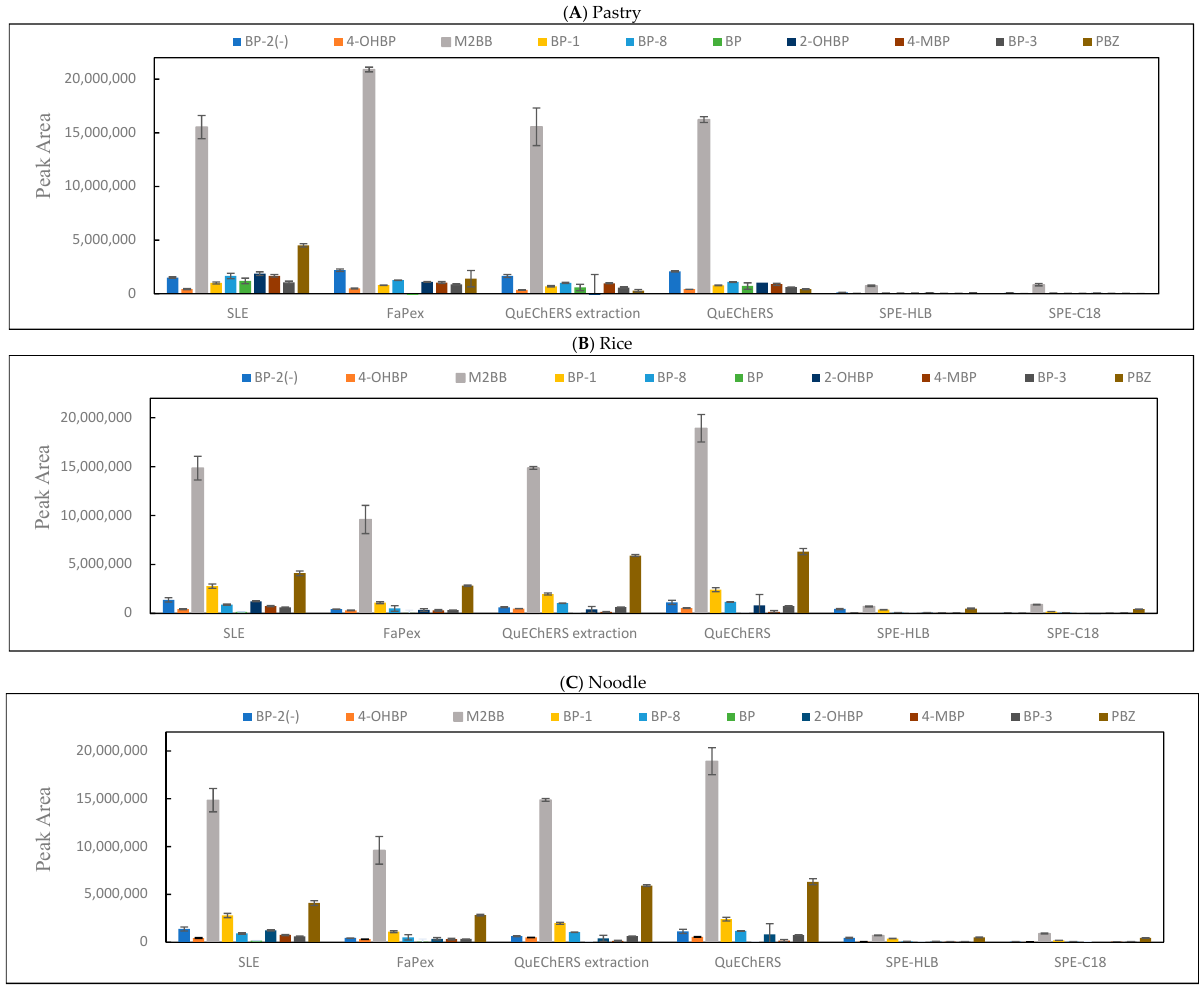
Figure 1. Comparisons of solid–liquid extraction (SLE), fast pesticide extraction (FaPEx), and quick, easy, cheap, effective, rugged, and safe (QuEChERS) using an extraction kit (4 g MgSO 4 + 1 g NaCl), QuEChERS using an extraction kit (4 g MgSO 4 + 1 g NaCl), and a cleanup procedure (0.24 g C18 + 0.24 g MgSO 4 + 0.08 g PSA), SPE with HLB, and SPE with C18 in samples ( n = 5 replicates) of ( A ) pastry, ( B ) rice, and ( C ) noodle spiked with standards and IS (20 and 8 ng/g).